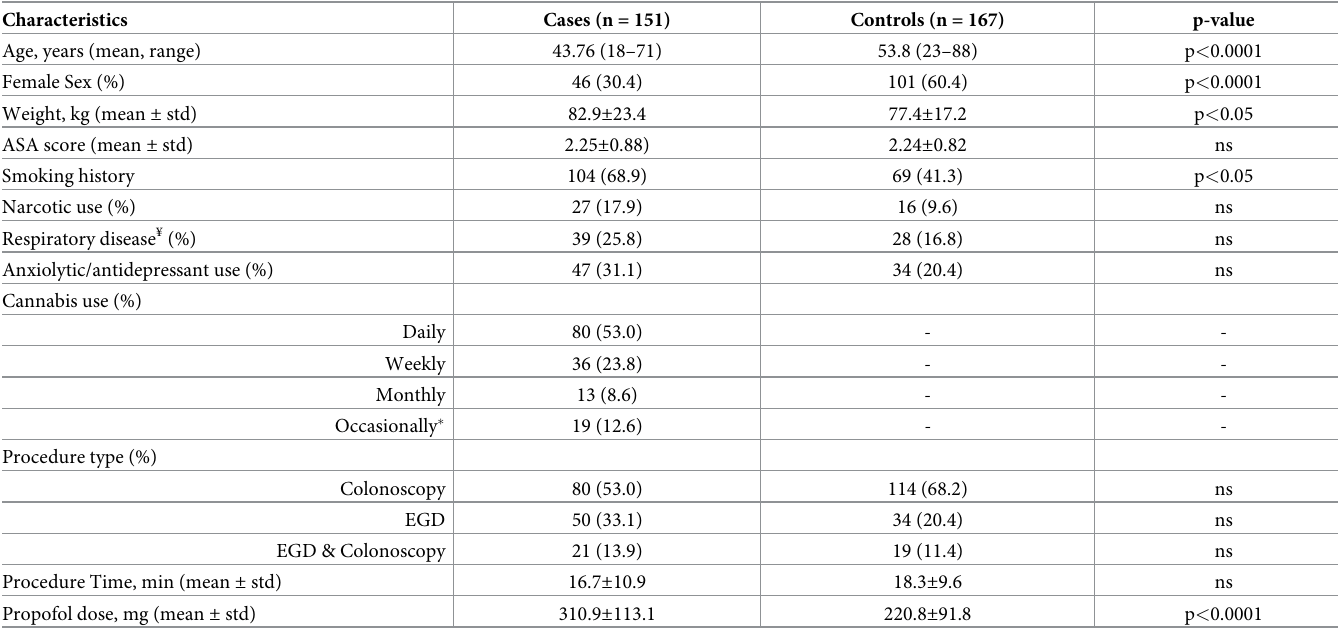
Table 1. Population